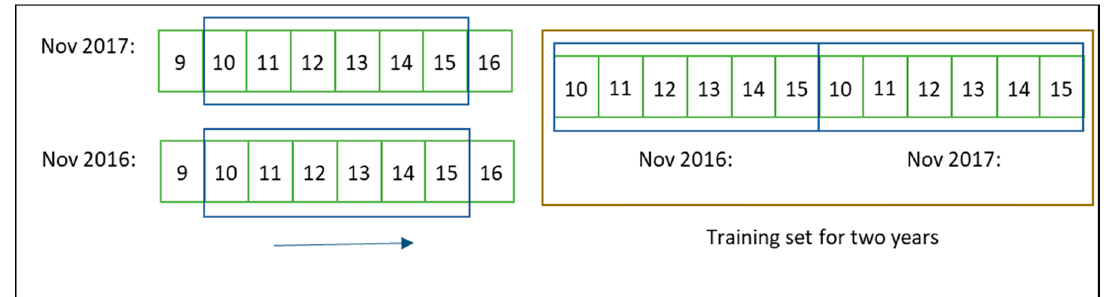
Figure 4. Example of sliding window with data from 2016 and 2017.